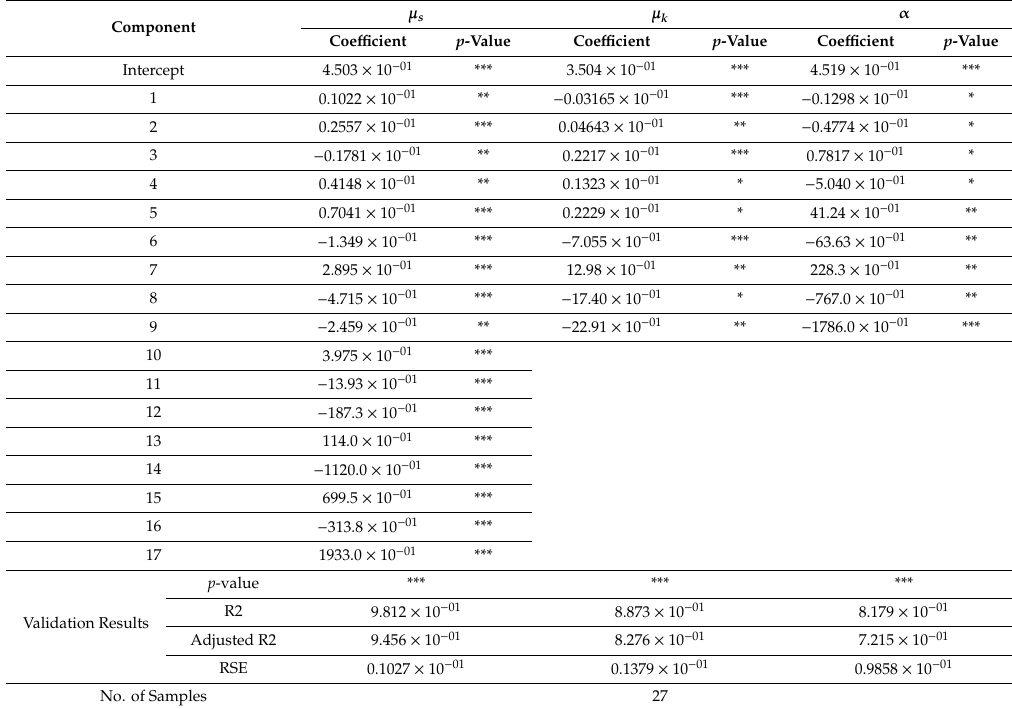
Table 5. PCA Regression results for the exponential decay friction